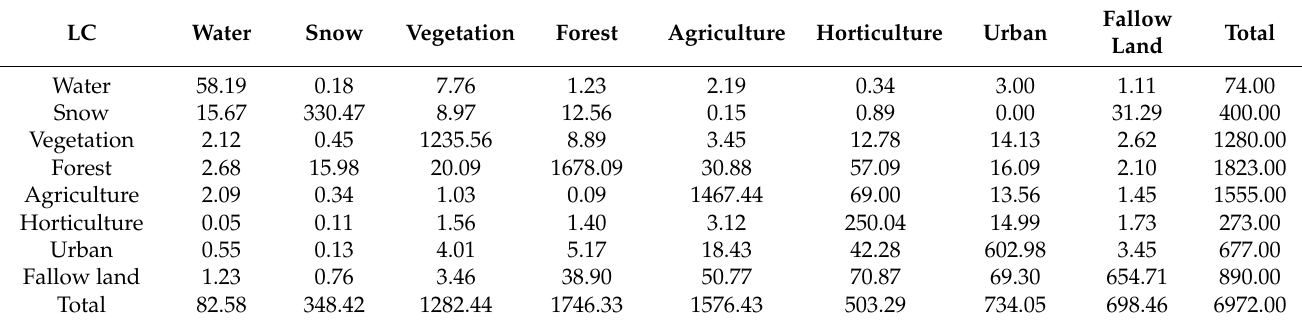
Table 7. Area transfer matrix from 2000–2010 (km 2